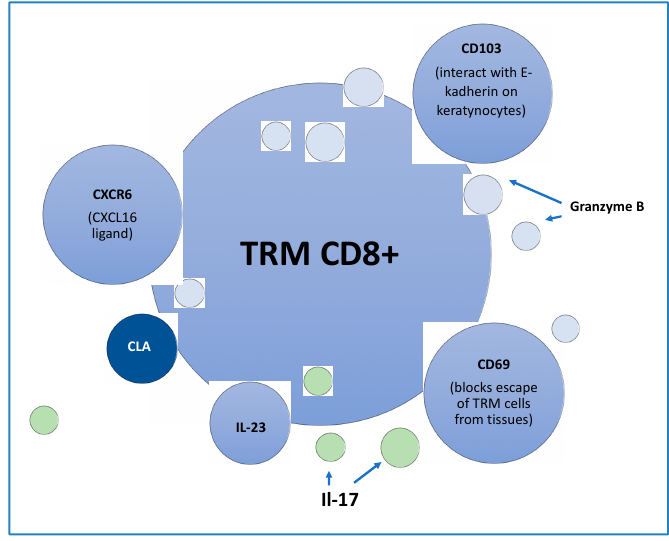
Figure 2. The receptors and secretory activity of tissue resident memory (TRM) CD8+ [5,22]